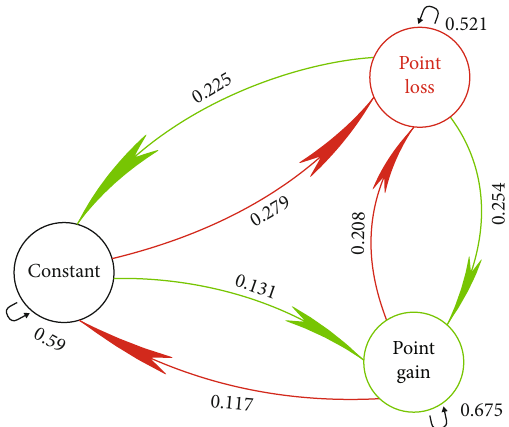
Figure 9: Republic Bank Plc equity transition matrix and diagram.